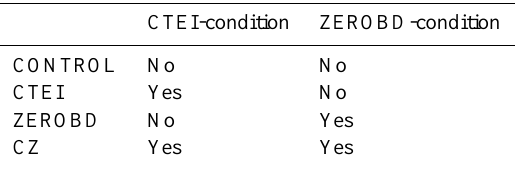
Table 1. List of experiments performed in this study.